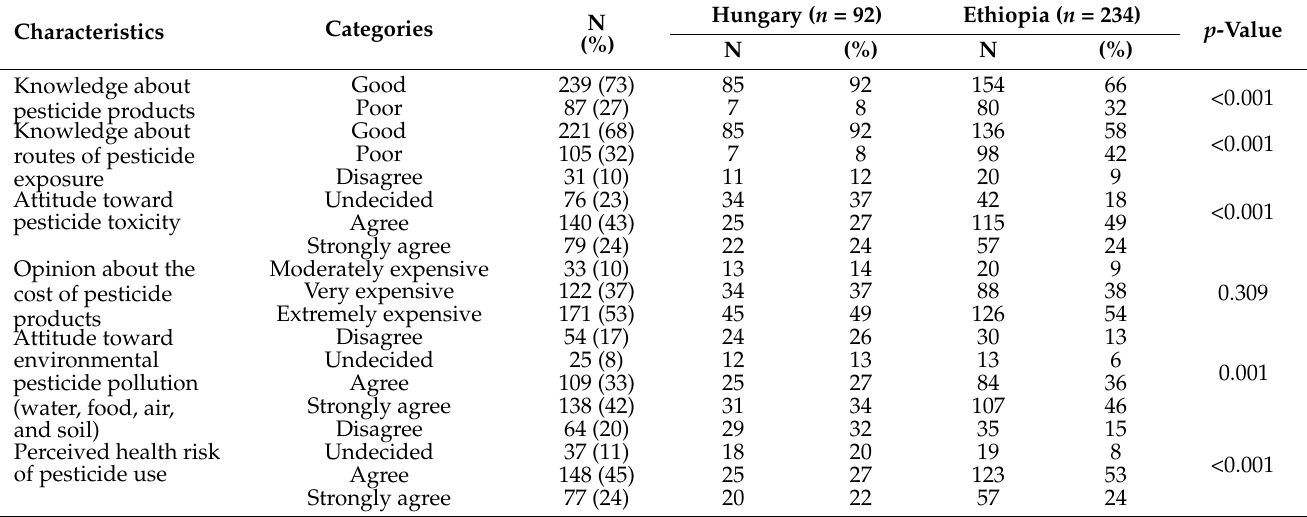
Table 4. Knowledge of and attitude to pesticides among officers in Hungary and